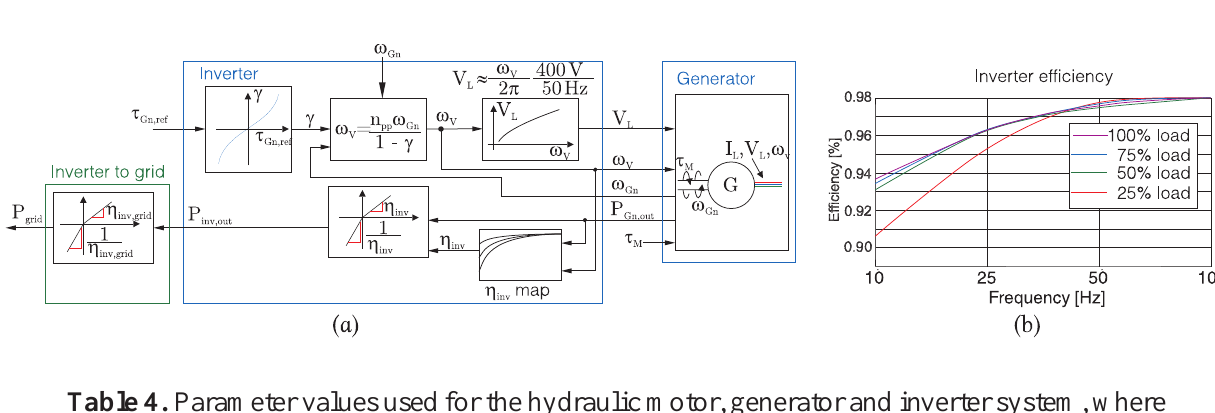
Figure 19. ( a ) torque control of the generator and inverter model; and ( b ) the efficiency map used for the inverter.